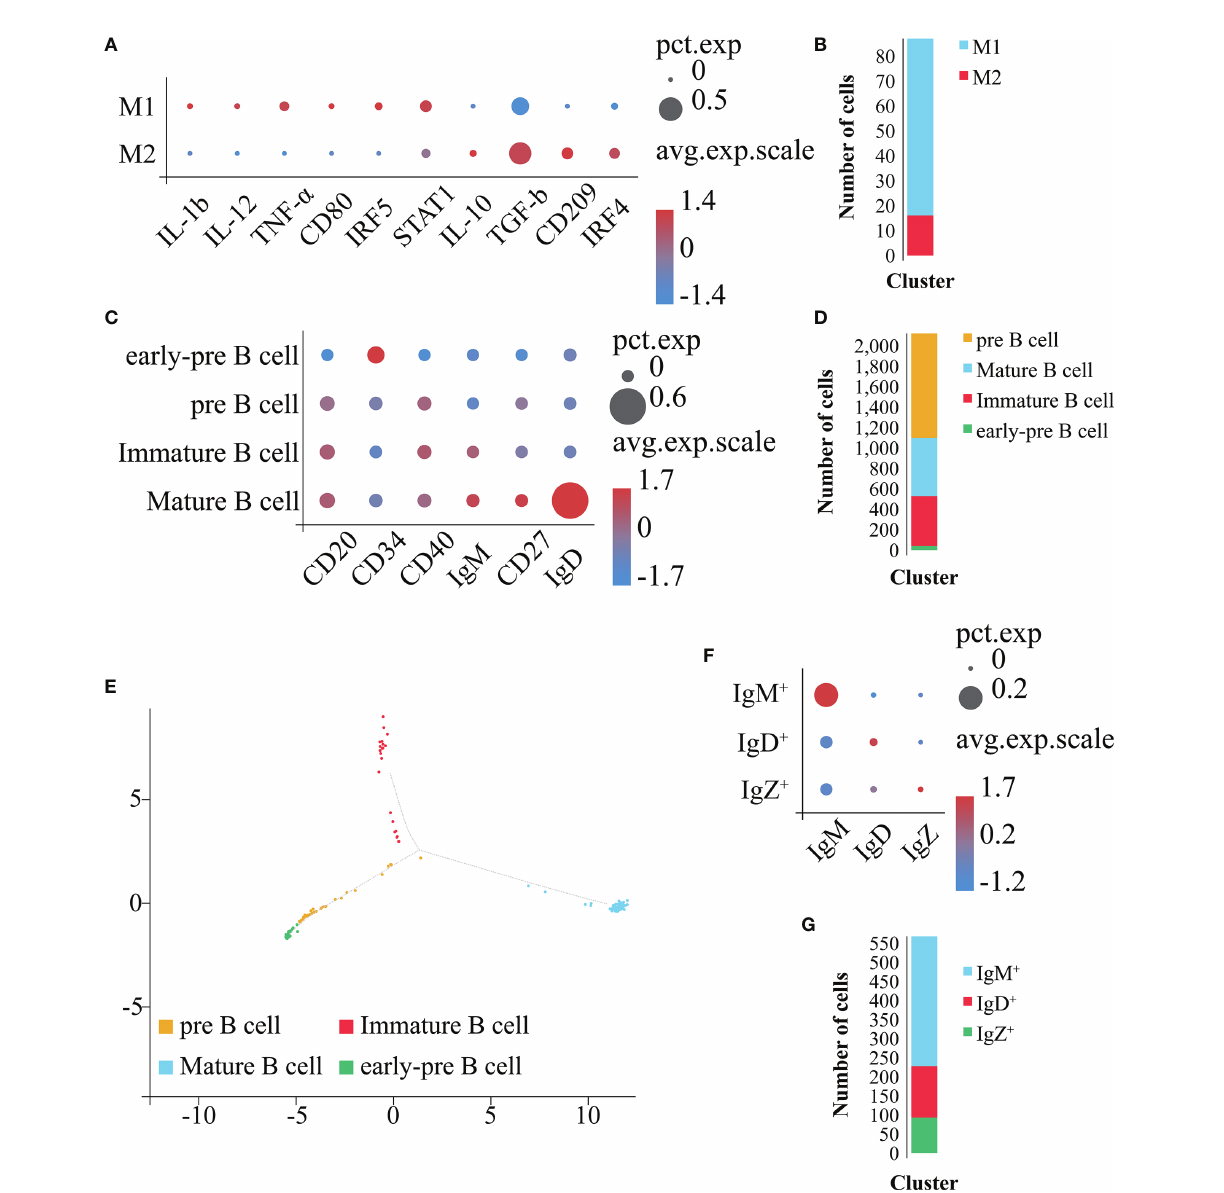
FIGURE 8 | Identi fi cation of Mo/M F and B cell subpopulations. (A) Bubble plot refers to molecular expression marker in Mo/M F clusters. X-axis is the name of the marker gene and Y-axis the name of the Mo/M F subpopulation; the size of the bubble represents the ratio of the sum of the marker gene expression in a certain subpopulation to the sum of its expression in all Mo/M F cells; the color of the bubble represents the average expression abundance of the marker gene in the Mo/M F subpopulation; the more red the bubble, the higher the average expression level of the marker gene in the Mo/M F subpopulation. (B) Identi fi cation of the 2 Mo/M F subpopulations based on marker molecules. Cell subpopulations are represented by different colors (M1 type Mo/M F : blue, M2 type Mo/M F : red). (C) Bubble plot refers to molecular expression marker in all B cell clusters. X-axis is the name of the marker gene and Y-axis the name of the B cell subpopulation; the size of the bubble represents the ratio of the sum of the marker gene expression in a certain B cell subpopulation to the sum of its expression in all B cells; the color of the bubble represents the average expression abundance of the marker gene in the B cell subpopulations; the more red the bubble, the higher the average expression level of the marker gene in the B cell subpopulation. (D) Identi fi cation of 4 B cell subpopulations based on the identi fi ed marker genes. The 4 cell subpopulations are represented by different colors (Mature-B cell: blue, pre B cell: orange, Immature-B cell: red, early-pre B cell: green). (E) Pseudo-time analysis of B cell subpopulations. Each subpanel corresponds to previously identi fi ed subpopulations as shown in (D) . (F) Bubble plot refers to molecular expression marker in mature B cell clusters. X-axis is the name of the marker gene and Y-axis the name of the mature B cell subpopulation; the size of the bubble represents the ratio of the sum of the marker gene expression in a certain mature B cell subpopulation to the sum of its expression in all mature B cells; the color of the bubble represents the average expression abundance of the marker gene in the mature B cell subpopulations; the more red the bubble, the higher the average expression level of the marker gene in the mature B cell subpopulation. (G) Identi fi cation of 3 mature B cell subpopulations based on the identi fi ed marker genes. The 3 cell subpopulations are represented by different colors (IgM + : blue, IgD + : red, IgZ + :